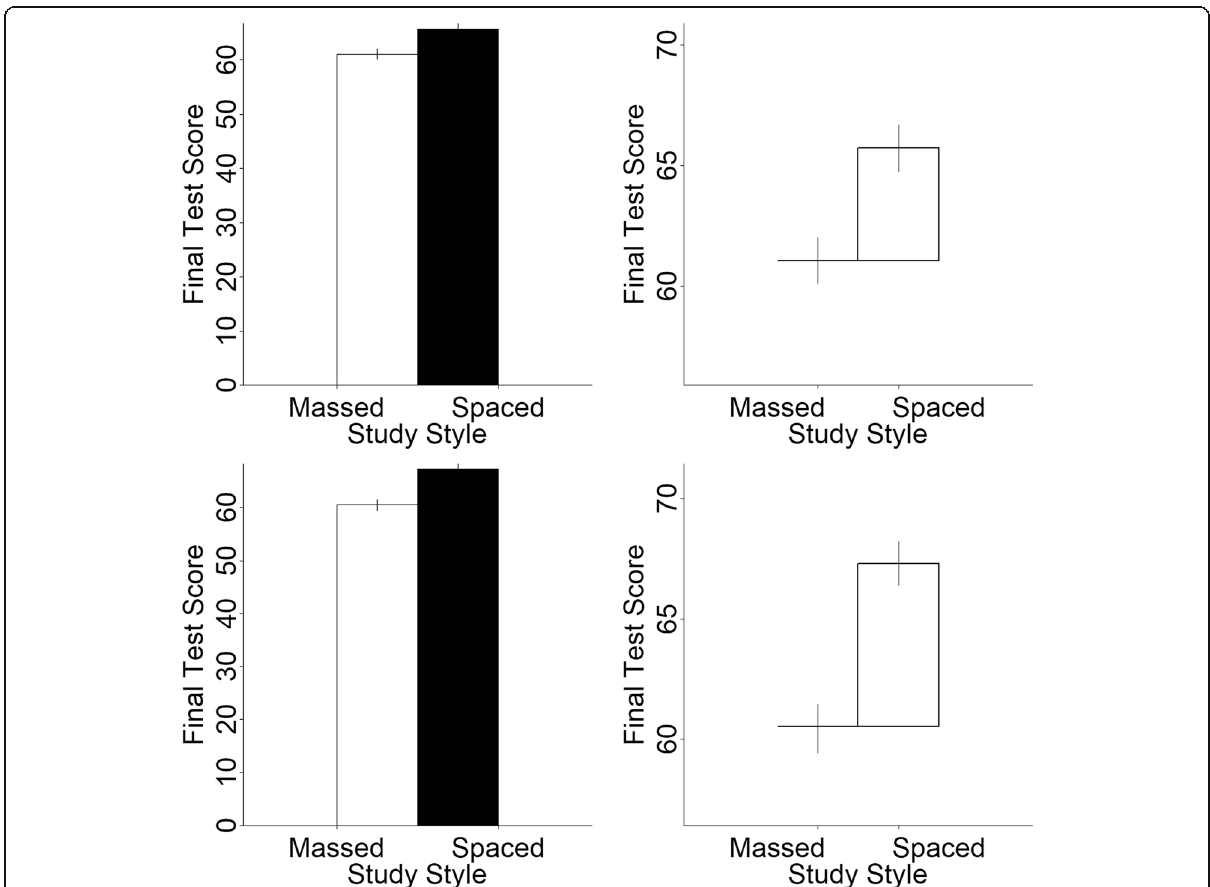
Fig. 11 Sample stimuli for experiment 3. The top row shows the bar graph and the hat graph for the same set of data, which depicts a medium effect, and the bottom row shows each graph depicting the same big